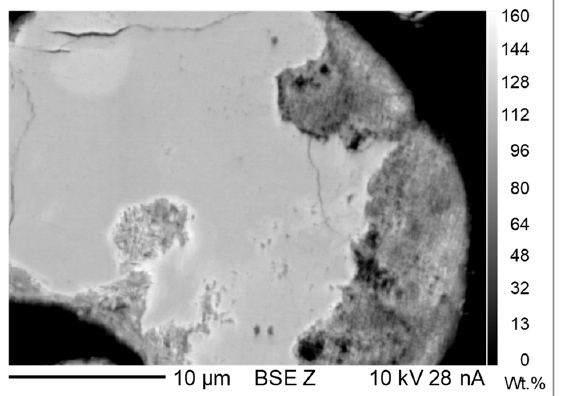
Figure 3. Backscattered electron micrograph (BSE(Z)) image of a particle of the monazite concentrate showing the typical needle shaped crystallites of the monazite.